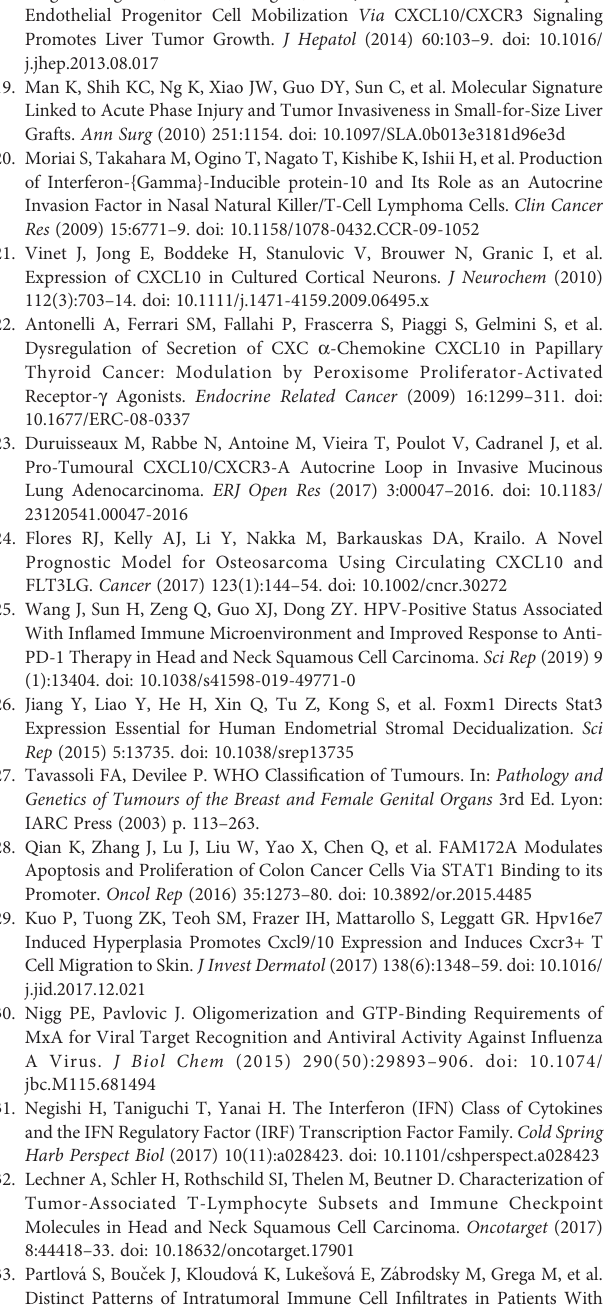
Supplementary Figure 2 | Identi fi cation of the exosomes by electron microscopy and markers; (A) The representative transmission electron microscopy image displaying the morphology and size of exosomes; Scale bars, 200 nm; (B) Result displayingtheCD63 and CD9 (exosomalmarker) immunoblot inH8andSiHa celllines.